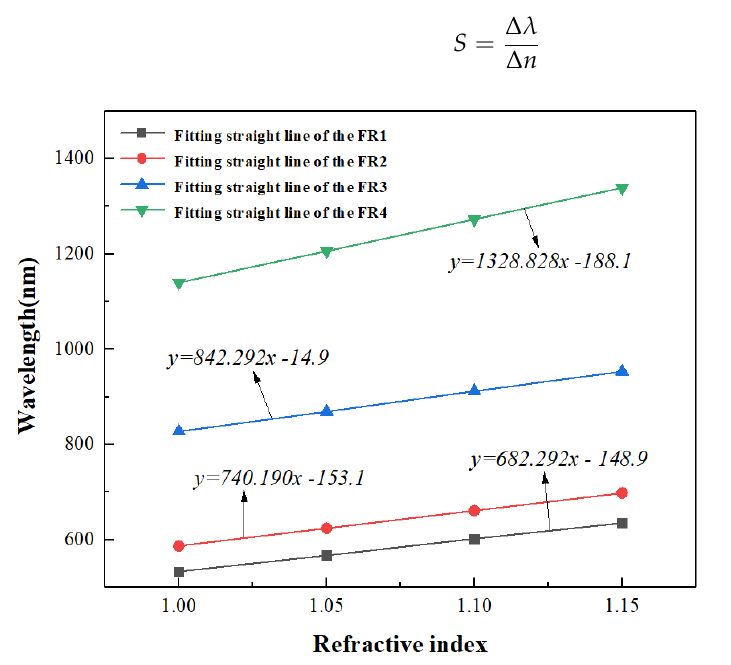
Figure 8. The relationship between the resonance wavelengths and the refractive index. Therefore, the sensitivity levels of the structure at different resonance wavelengths are 682.3, 740.2, 842.3, and 1328.8 nm/RIU, respectively. It should be noted that, compared with FR1, FR2, and FR3, FR4 has the greatest sensitivity. From Equation (2), it can be seen that the sensitivity is proportional to l1/m. It can be seen from Figure 3 that the effective length of the resonators of FR1 and FR2 and FR3 are the same, but the order of the resonant mode of FR1 is larger. Therefore, the sensitivity of FR1 is less than FR2 and FR3. The